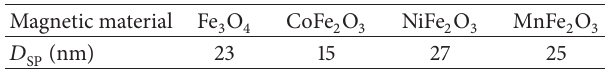
Table 3: The critical size of transform to superparamagnetic state for some common magnetic materials.